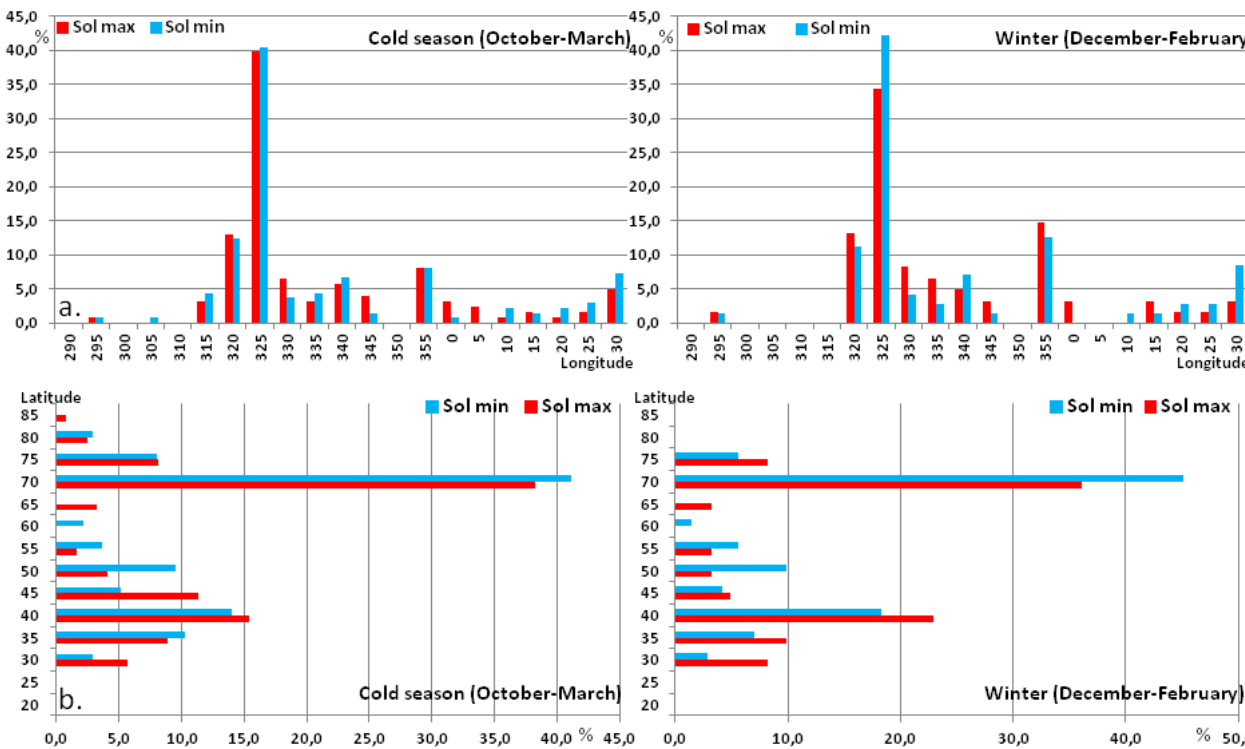
Figure 4. (a) Longitudinal relative frequency of the minimum SLP occurrence during cold season (left) and winter (right) for different solar activity conditions. (b) Latitudinal relative frequency of the minimum SLP occurrence during cold season (left) and winter (right) for different solar activity